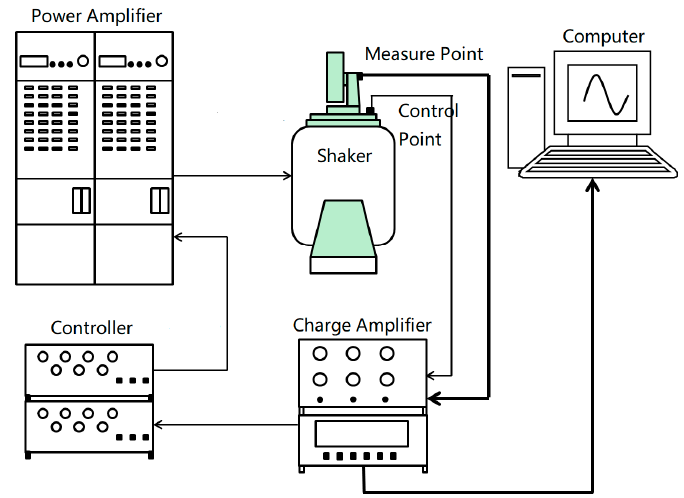
Figure 4. Schematic of experimental apparatus.